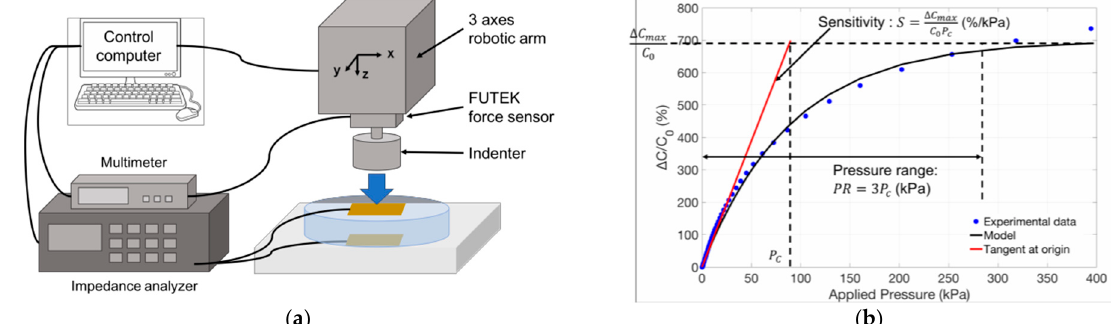
Figure 3. ( a ) Electromechanical test bench ( b ) Typical sensor response and first order exponential behavior model allowing sensor sensitivity (S) and pressure range (PR) to be